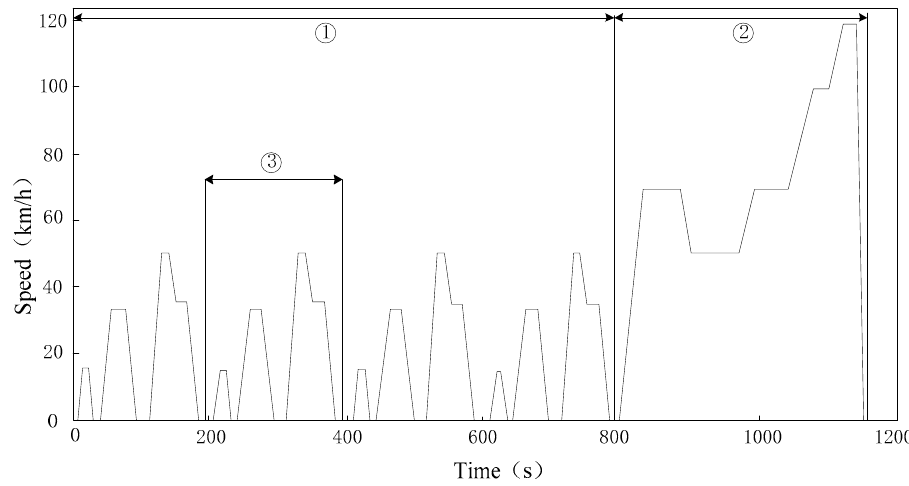
Figure 13. The New European Driving Cycle. 314